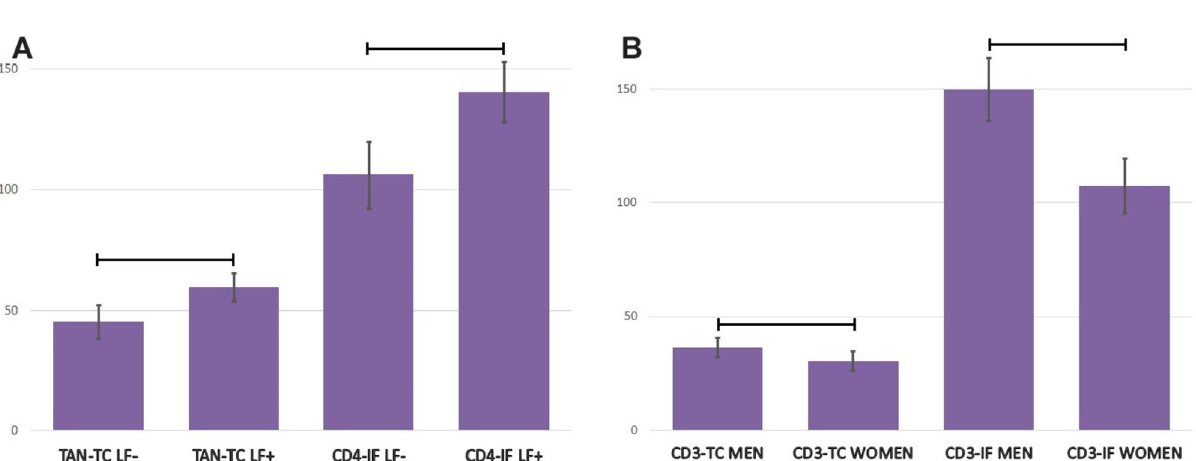
Figure 4. ( A ) The densities of tumor-infiltrating lymphocytes CD3 in invasive front in colorectal cancer tissue of patients with different stages of cancer according to TNM classification. Data are presented as means and standard errors. Horizontal lines indicate significant differences at p < 0.05. ( B ) The densities of tumor- infiltrating lymphocytes CD3 in invasive front and tumor center in colorectal cancer tissue of patients with different depth of cancer invasion, divided into two groups (T1 + T2 vs T3 + T4). Data are presented as means and standard errors. Horizontal lines indicate significant differences at p < 0.05.